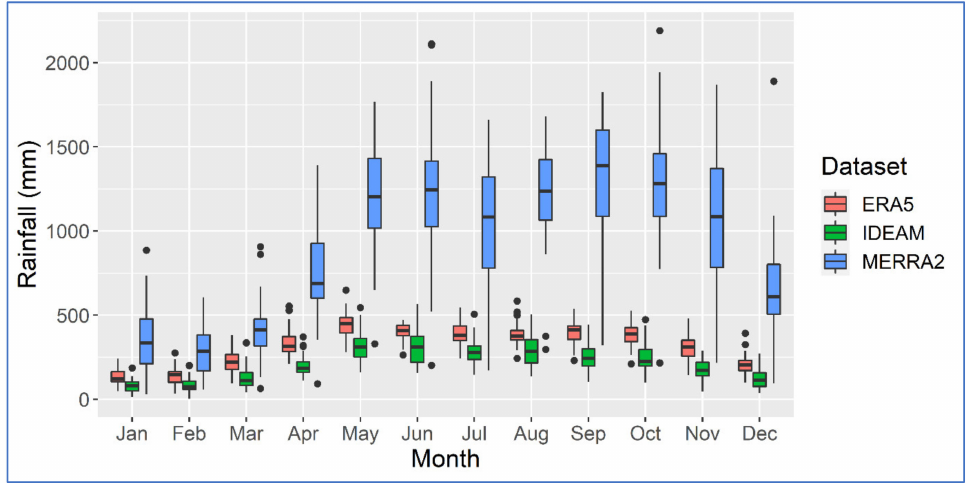
Figure 5. Average monthly rainfall in the Upper Sin ú River basin based on the three datasets for 1985–2019. In this boxplot, the extremes of the box are the first (Q1) and third (Q3) quartiles; the bar indicates the median; the whiskers correspond to Q1—1.5 IQR and Q3 + 1.5 IQR. The points are potential outliers.